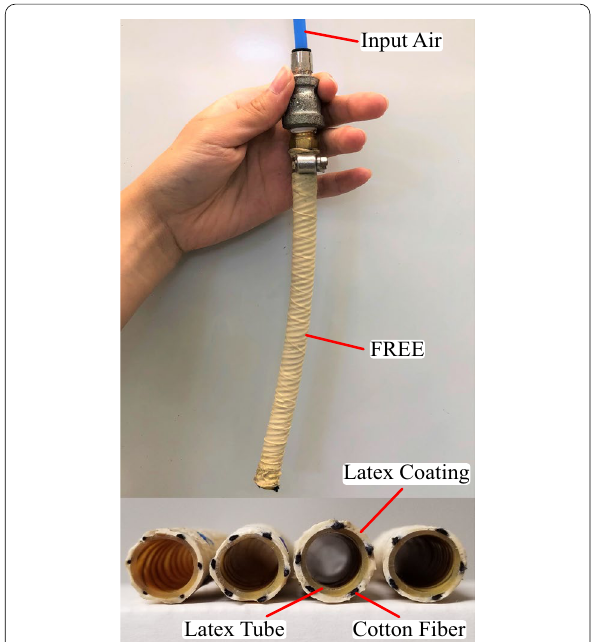
Fig. 2 Fiber-Reinforced Elastomeric Enclosure (FREE). A single FREE connected to input pressurized air (top). Cross-sections of various FREEs